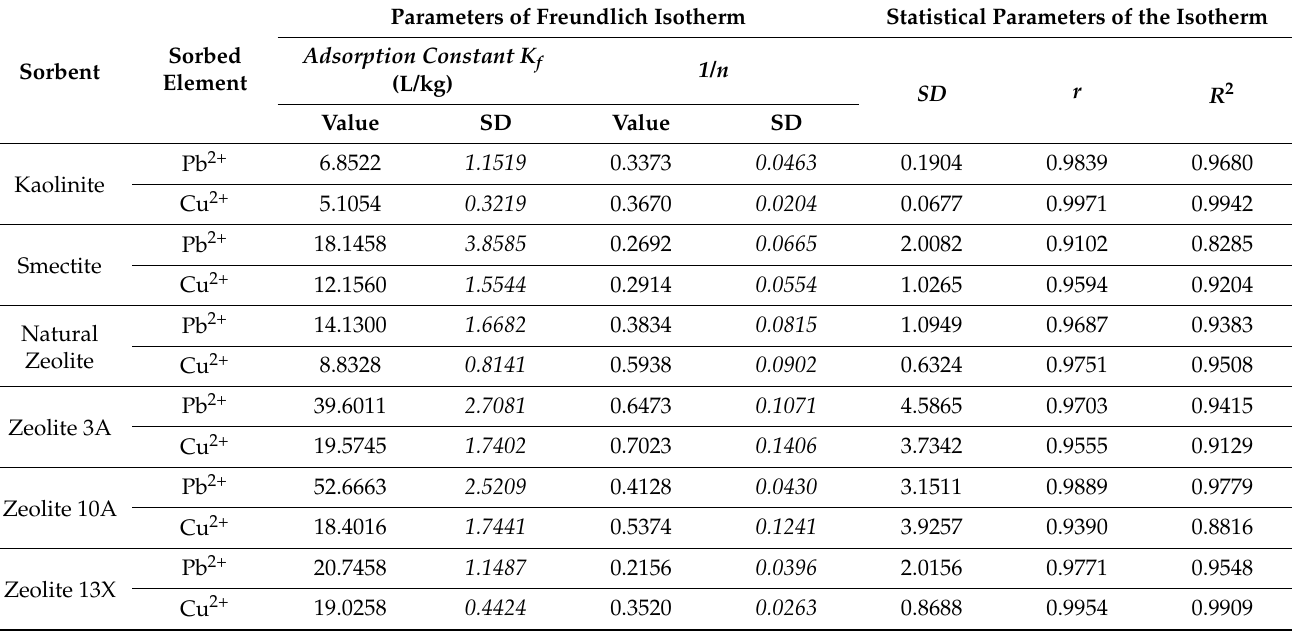
Table 4 for the Freundlich model and Table 5 for the Langmuir model. The plotted Fre- undlich isotherms are presented in Figures 1 and 2 and plots of Langmuir isotherms in Figures 3 and 4. The isotherms, represented by red solid lines with blue dots for the ex- perimental points, are plotted with their Confidence Bands, determined at two levels of confidence—95% and 90%, marked using dark pink and light pink, respectively (dark grey and light grey, respectively, if reproduced in black-and-white format). Table 4. Parameters of Freundlich isotherms and isotherms’ statistical evaluation.